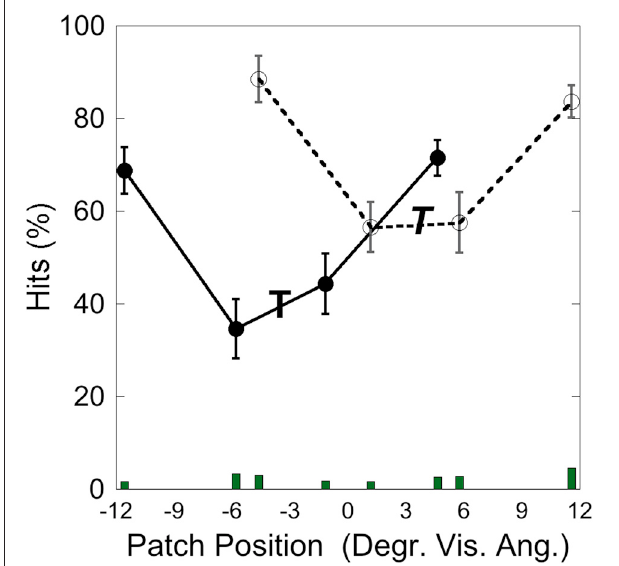
FIGURE 12 | Experiment 4: hits and false alarms as a function of patch position. The “T” marks the position of the target at − 3 . 5 ◦ , the italic “ T ” indicates the target position at + 3 . 5 ◦ . Solid lines and filled circles show hits on the − 3 . 5 ◦ , target, dotted line and unfilled circles show hits on the + 3 . 5 ◦ target. The columns on the bottom depict false alarms as a function of patch position. Black bars depict standard errors.